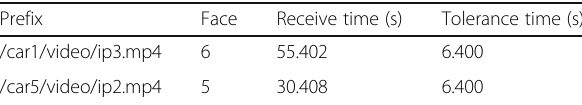
Table 2 The improved